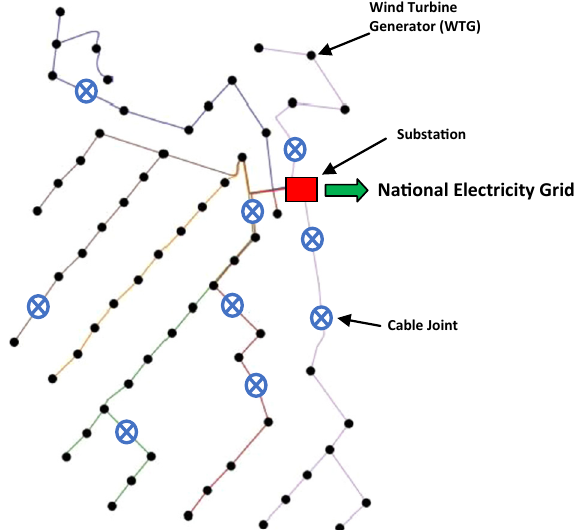
Fig. 1. Typical wind farm collector circuit layout showing cable joints in long cable run.